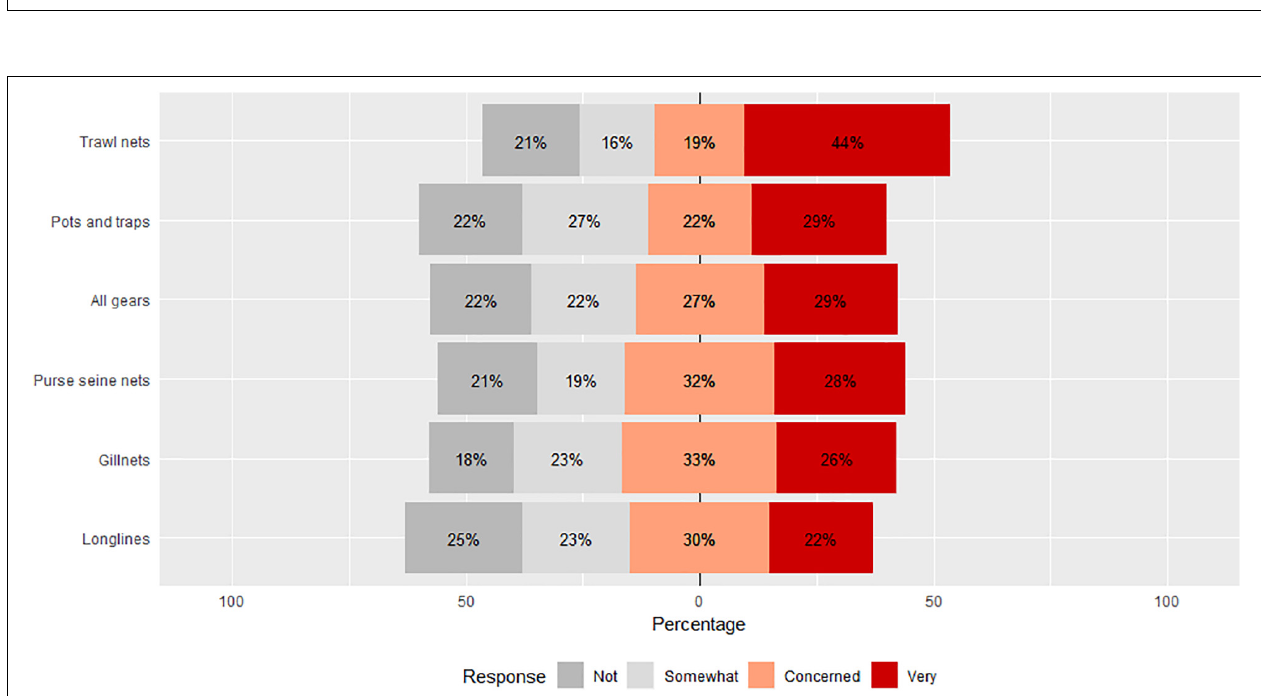
FIGURE 3 | Gear loss prevention practices, for all gear types and countries combined. Less common prevention practices are presented on the left side of the figure in dark to light grays, leading to more common prevention practices as the reader moves right and the colors warm from orange to salmon to red. Reading left to right, responses from fishers ranged from “never,” “rarely,” “sometimes,” “often,” or “always” engaging in these gear loss prevention practices. Total percentages are reported for each response and presented over the associated color code.